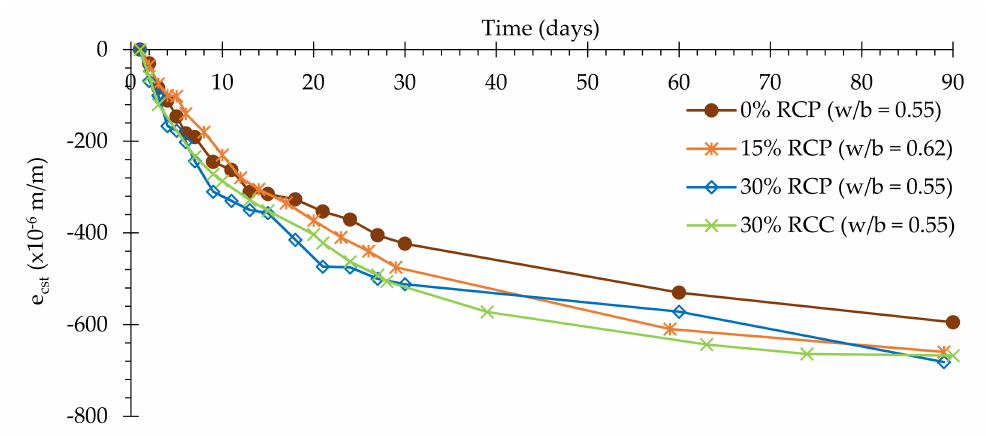
Figure 24. Drying shrinkage, e cst , of concrete with a w/b of 0.55 incorporating 30% of different additions (RCP and RCC) and concrete with the same workability without SP (0% RCP w/b = 0.55 and 15% RCP w/b = 0.62), up to 90